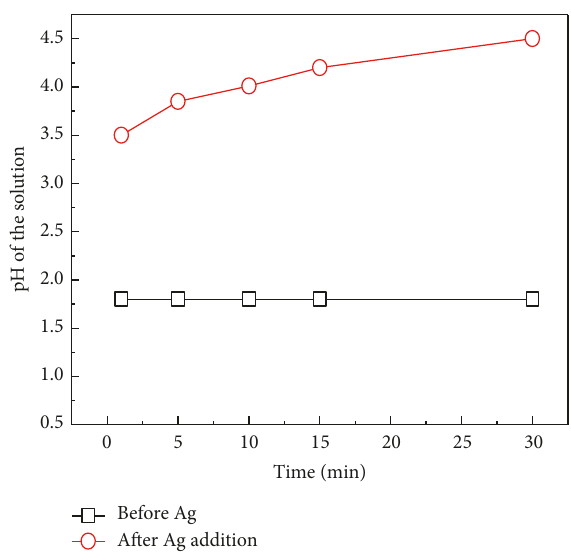
Figure 1: The pH variation during ball milling process.